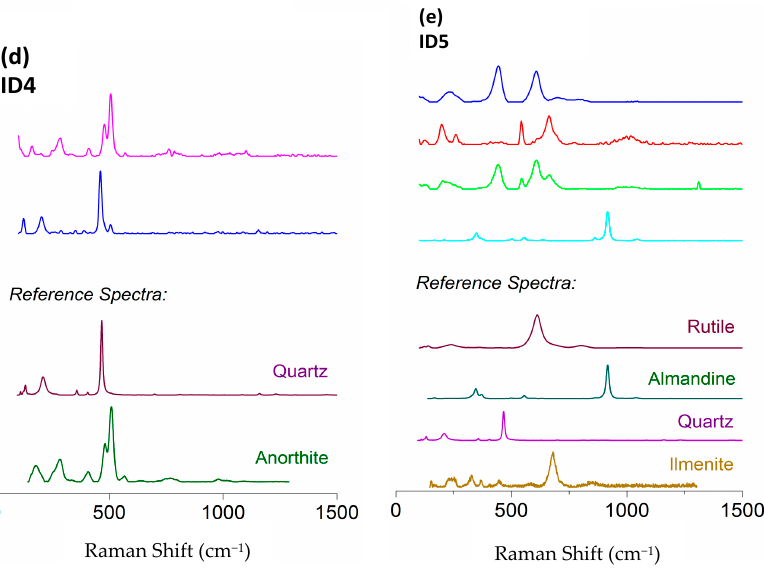
Figure 4. Micro-Raman scattering measurements of samples ID# (# = 1, . . . , 5) ( a – e ). Quartz (RRUFF ID: R040031) was clearly identified in all the investigated samples.